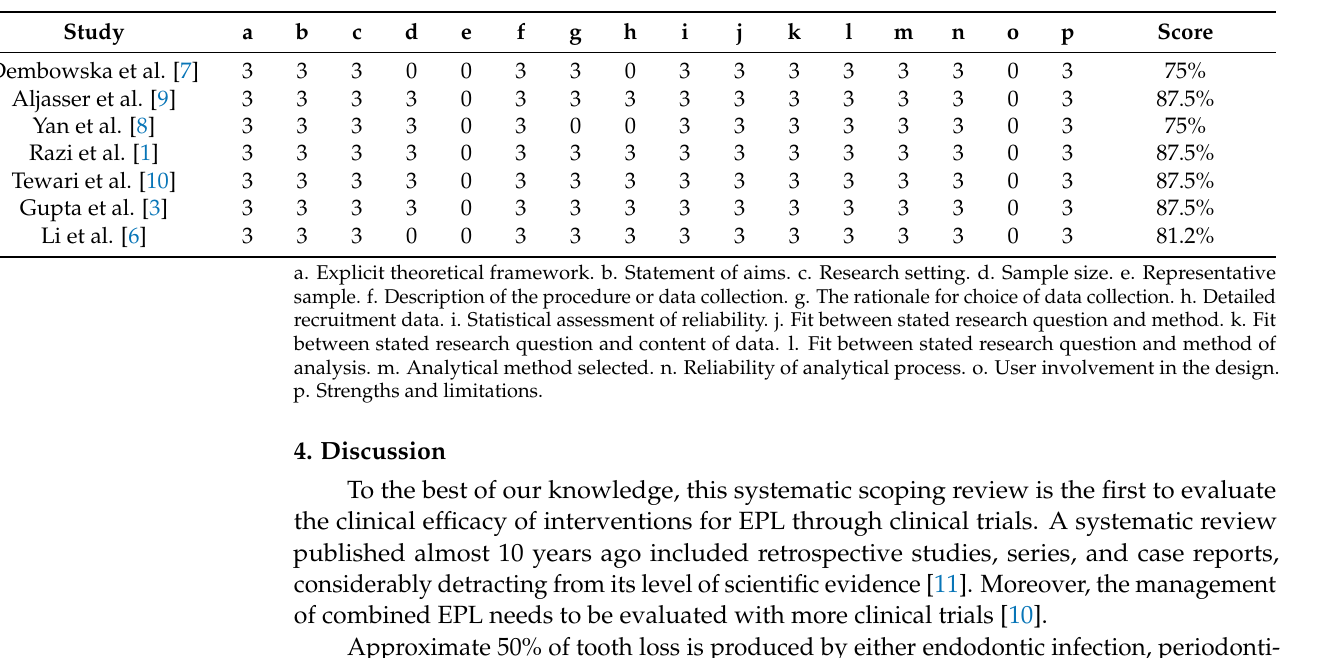
Table 2. Quality of the chosen studies